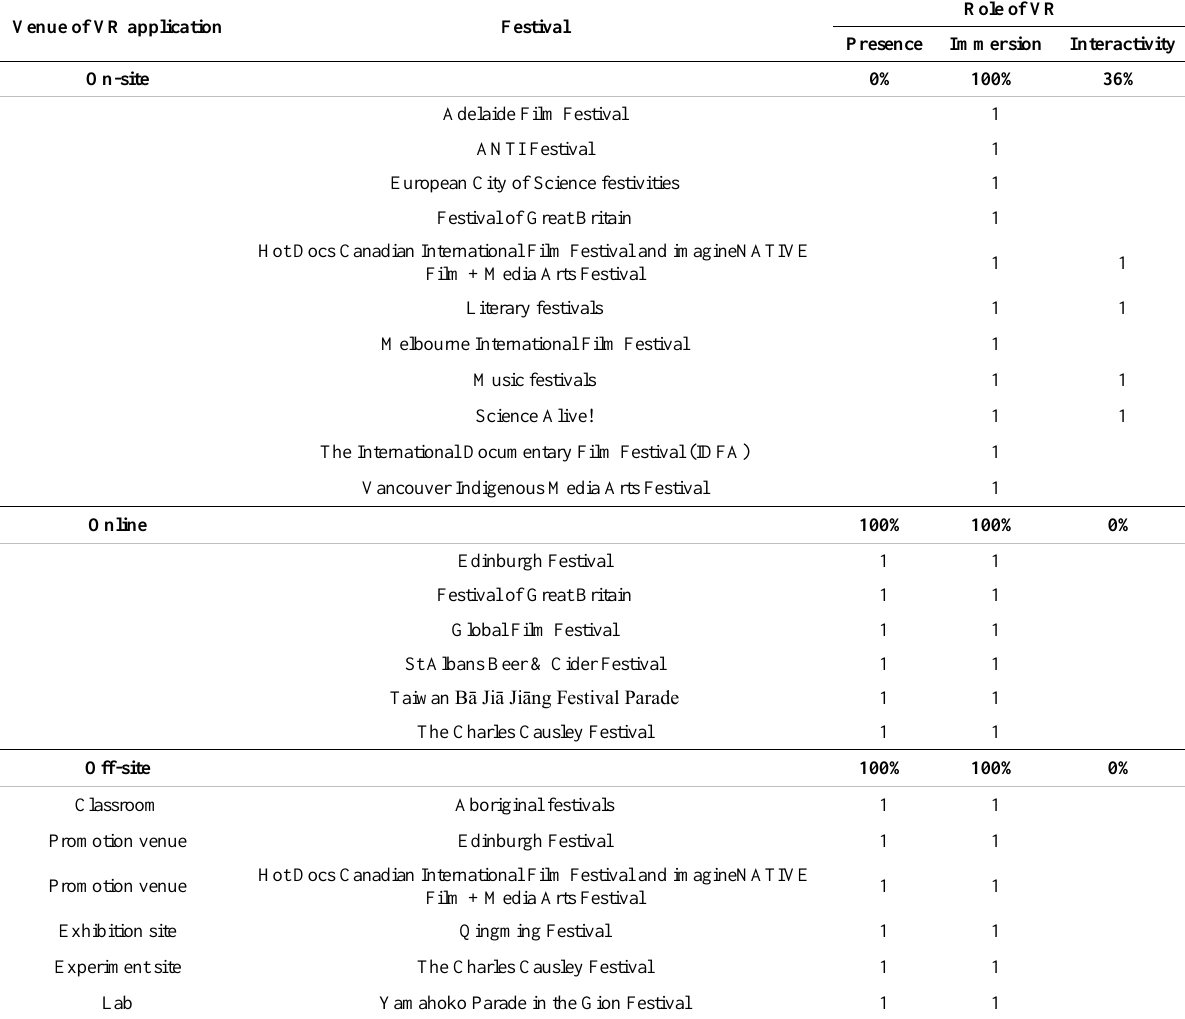
Table 5. Venues and roles of VR